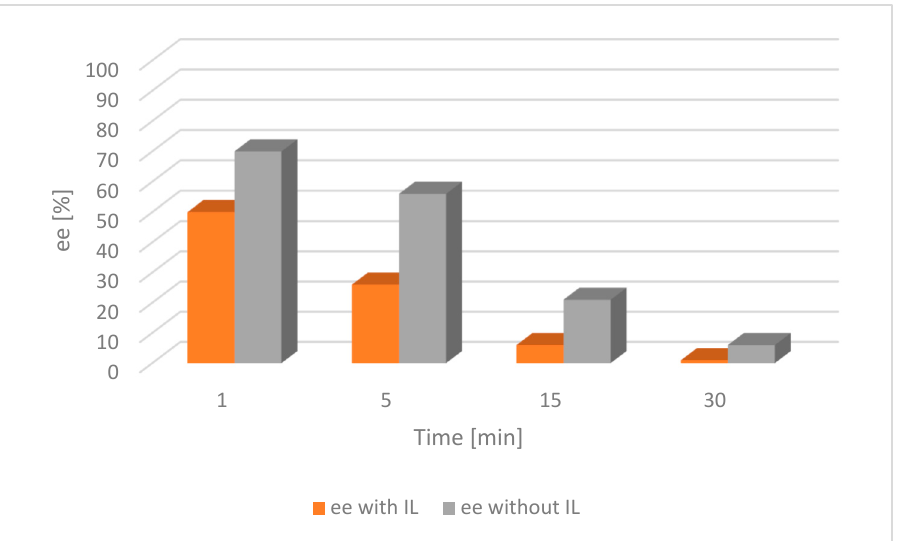
Figure 5. Comparison of the catalytic activity of [Ru(2)] with and without an IL for alcohol 1. [Ru(2)] 0.004 mmol, t BuOK 0.02 mmol, alcohol 0.25 mmol, [BMIM][NTf 2 ] 0.07 mmol, toluene 2 mL, a nitrogen atmosphere, RT; ee—enantiomeric excess of chiral alcohol in the mixture; the lower the ee, the nearer completion the desired racemization reaction.